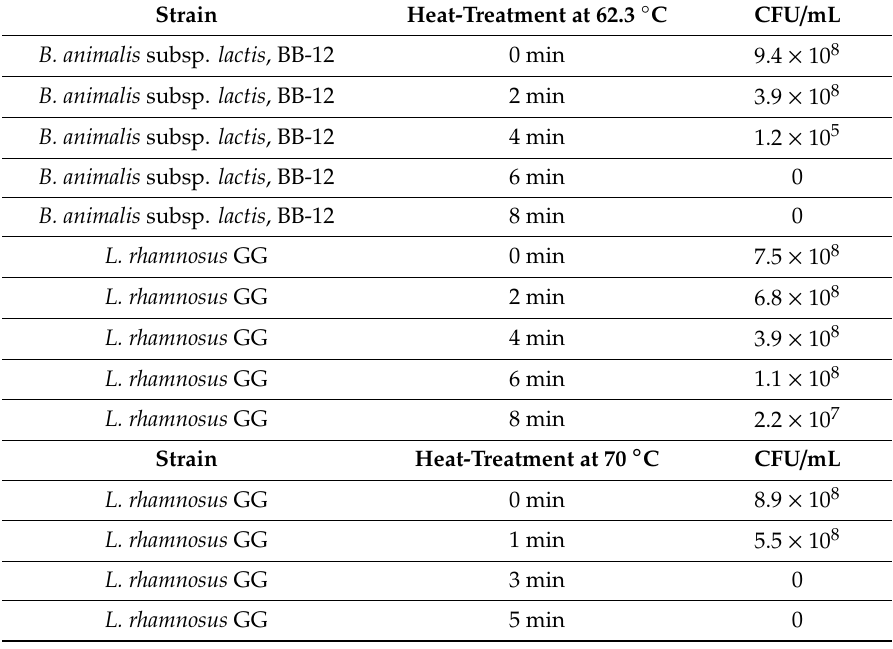
Table 1. E ff ect of heat-treatment for di ff erent times on numbers of L. rhamnosus GG and B. animalis subsp. lactis ,